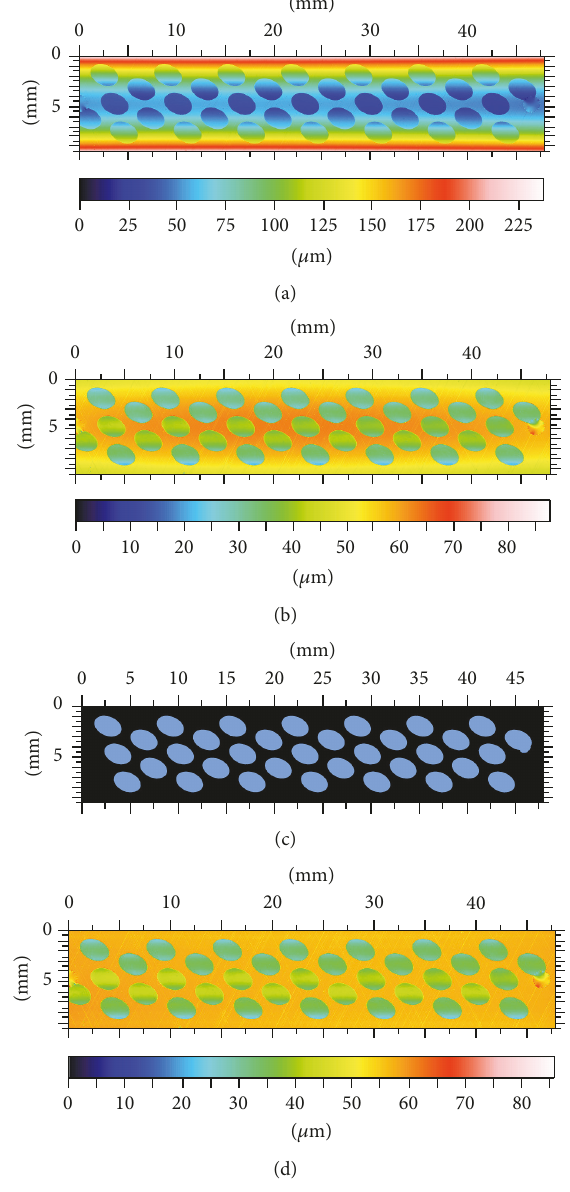
Figure3:Exampleofformremovalonatexturedsurfacebyremoval of the significant texture prior to form removal and the consecutive adding of segmented features. (a) Original surface measurement.